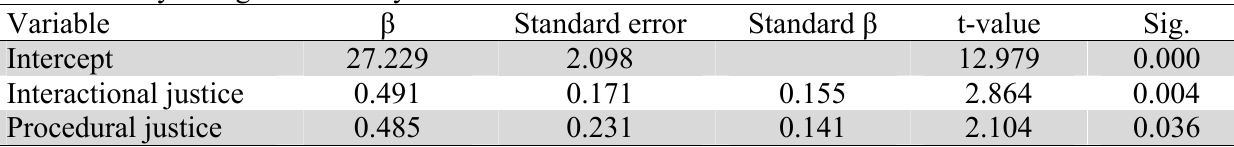
The summary of regression